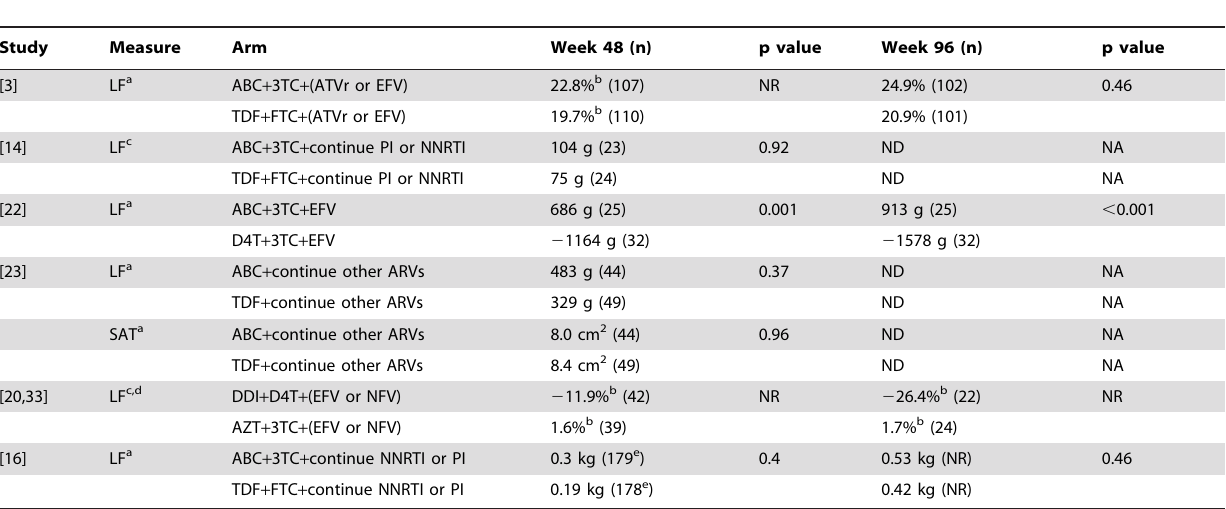
Table 4. Change from baseline in limb fat (LF) on DEXA scan and subcutaneous adipose tissue (SAT) on CT scan: NRTI versus NRTI.